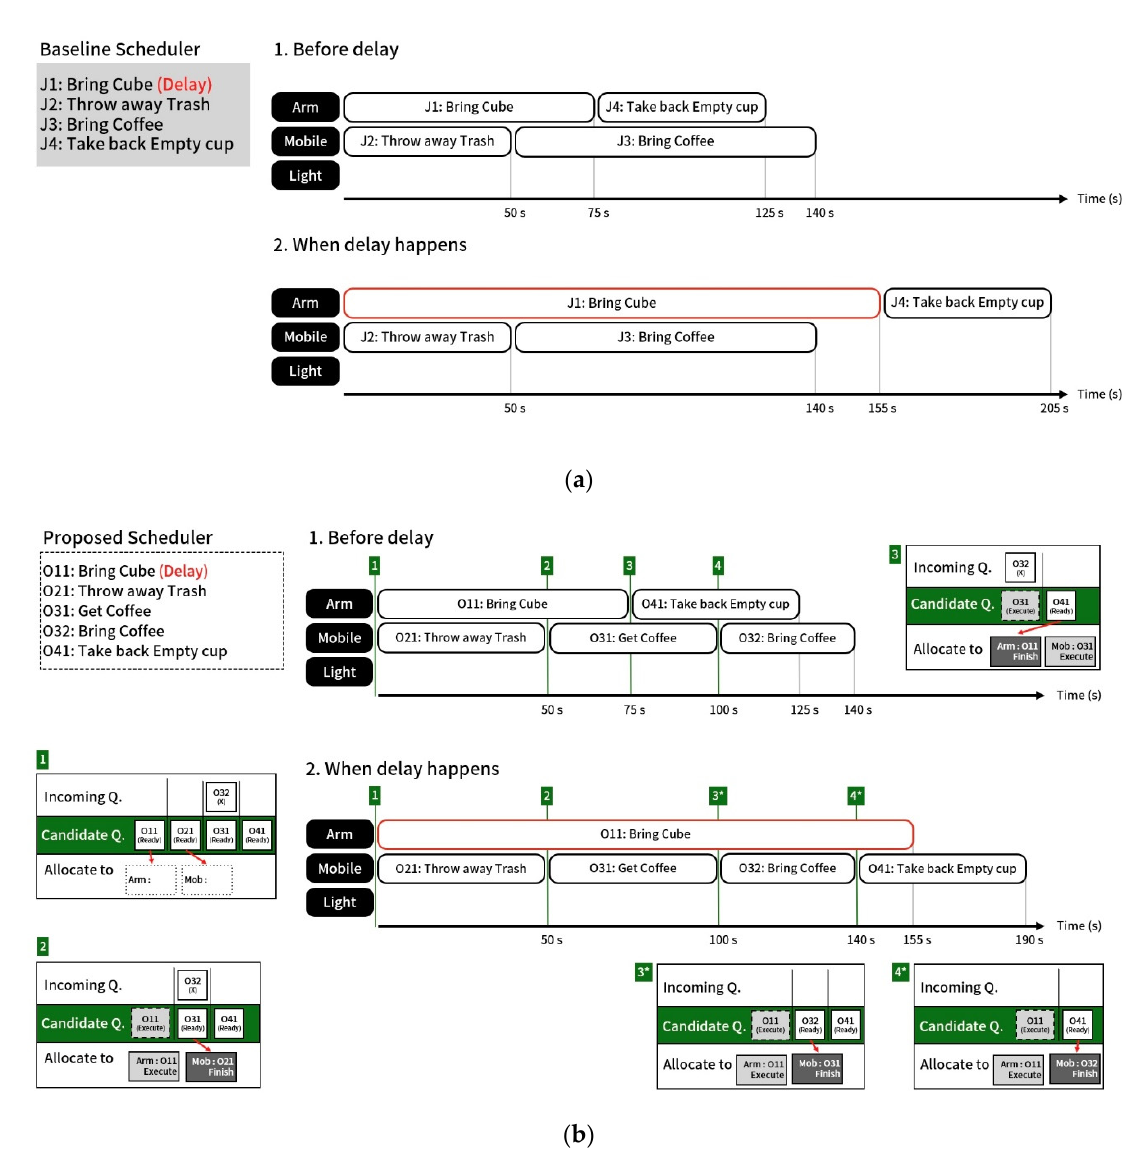
Figure 5. Delay occurs: ( a ) the baseline scheduler and ( b ) the proposed